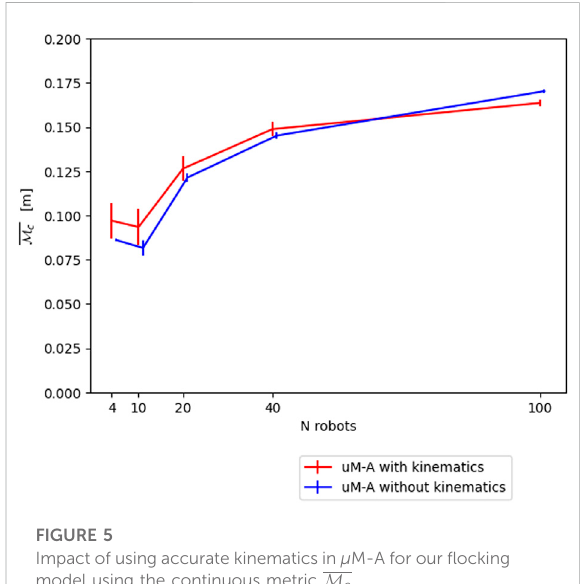
FIGURE 5 Impact of using accurate kinematics in μ M-A for our fl ocking model using the continuous metric M c